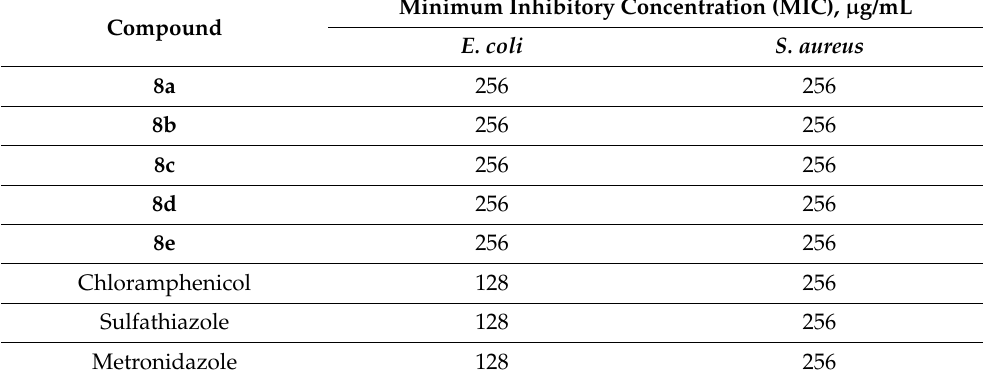
Table 1. Results of studying the antibacterial activity of 2-thioxo-1,2,3,4-tetrahydro-6H-pyrim-